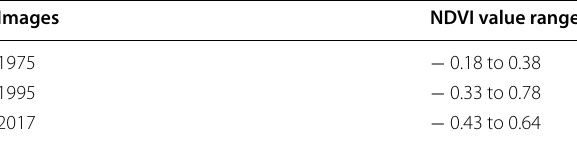
Table 5 NDVI value for the year of 1975, 1995 and 2017